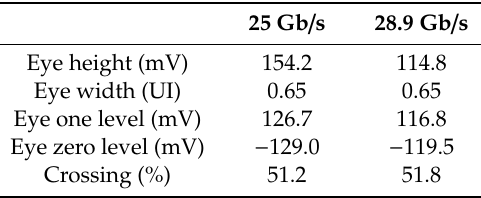
Figure 19. Measured eye diagrams of the optical receiver. ( a ) 25 Gb / s; ( b ) 28.9 Gb / s. Table 1. Measured results of the eye diagrams.